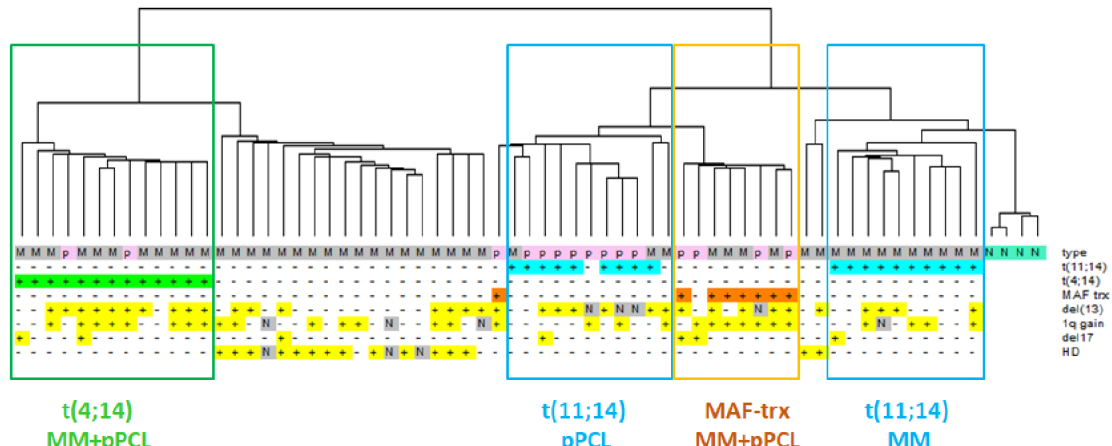
Figure 1. Hierarchical clustering analysis of gene-expression profiles of 50 MM (grey), 15 pPCL (pink) and 4 N samples (green). Samples are grouped according to the expression levels of the 2402 most variable transcripts (varying at least 2-fold in expression levels from the mean across the dataset). Main molecular alterations are shown; N indicates data not available. The specific types (N = normal control, M = MM, p = pPCL) are enriched by colored sub-branches, also highlighted by the appropriately colored box (see